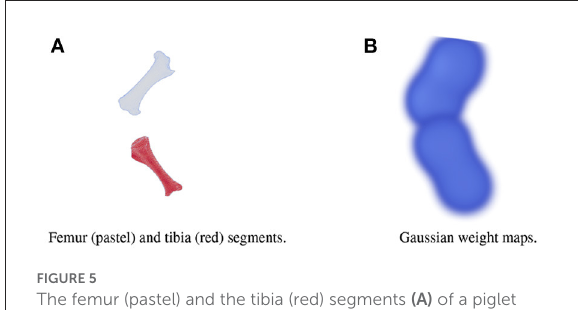
FIGURE5 The femur (pastel) and the tibia (red) segments (A) of a piglet hindlimb and their Gaussian weight maps (B) .